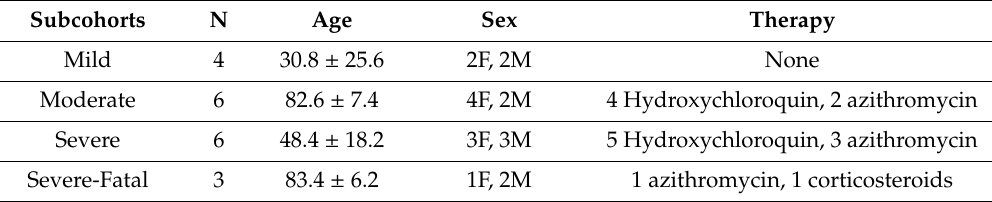
Table 1. Demographic and clinical characteristics of COVID-19